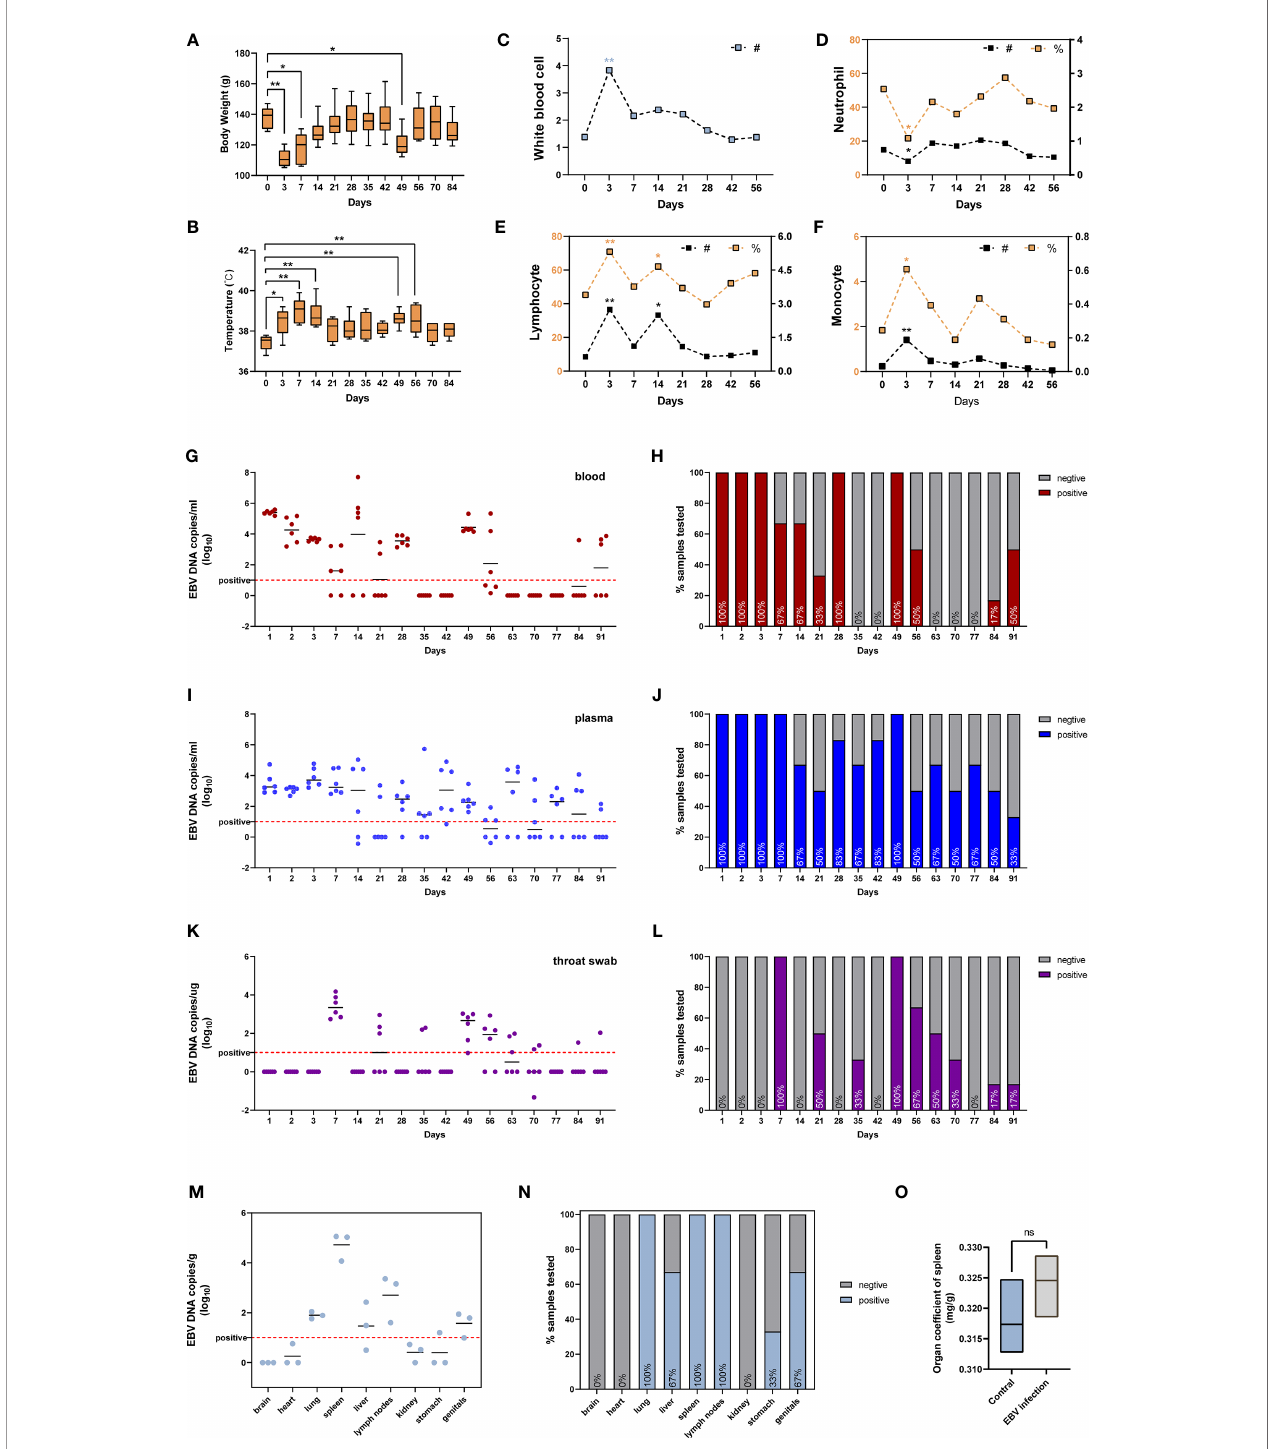
FIGURE 4 | Characterization of tree shrews with EBV infection in vivo . (A) The body weight and (B) rectal body temperatures changes, presented as mean and standard deviation (SD). Routine blood test, including (C) white blood cell, (D) neutrophil, (E) lymphocyte, and (F) monocyte presented as mean; # represents absolute count (10 9 /L), % represents a percentage (%). The kinetics and time courses of the viral loads in (G, H) blood, (I, J) plasma, and (K, L) saliva samples, determined by qPCR. The detection limit is indicated by the dotted line. (M, N) qPCR detection of viral loads in different tissues of EBV infected tree shrews at 91 dpi. (O) Organ coef fi cient of the spleen in EBV infected tree shrews and control groups at 91 dpi. *p<0.05, **p<0.01, ns P >